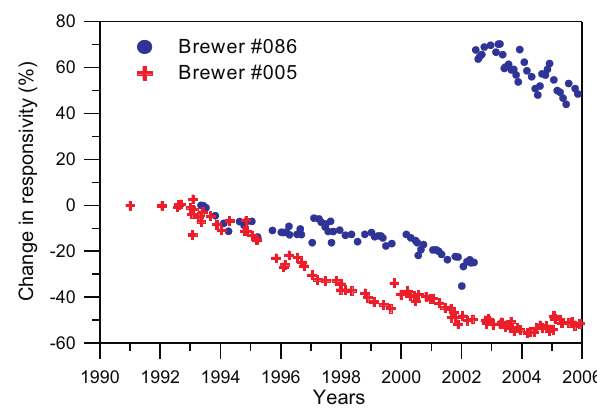
Fig. 2. Time series of the percentage change in the responsivity of the two Brewer spectroradiometers at 320 ± 5 nm, with respect to the first calibration in their records. The calibration factors have been corrected for temperature effects to a standard temperature of 25 ◦